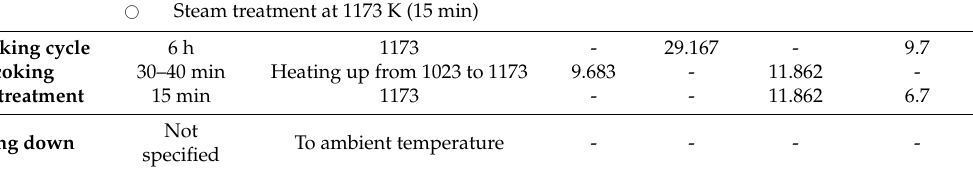
Table 2. Procedure of metallurgic aging followed by a single coking-decoking cycle.